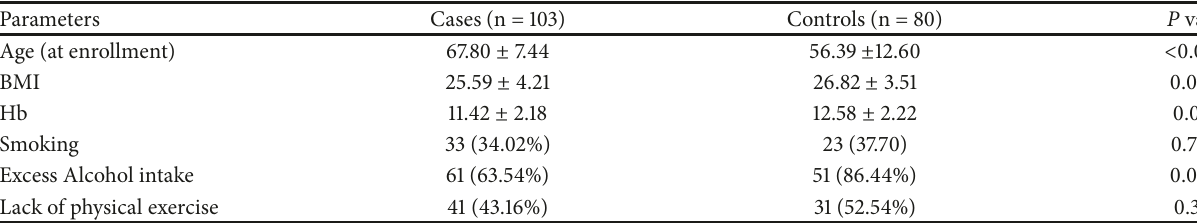
Table 1: Sociodemographic characteristics of study subjects.